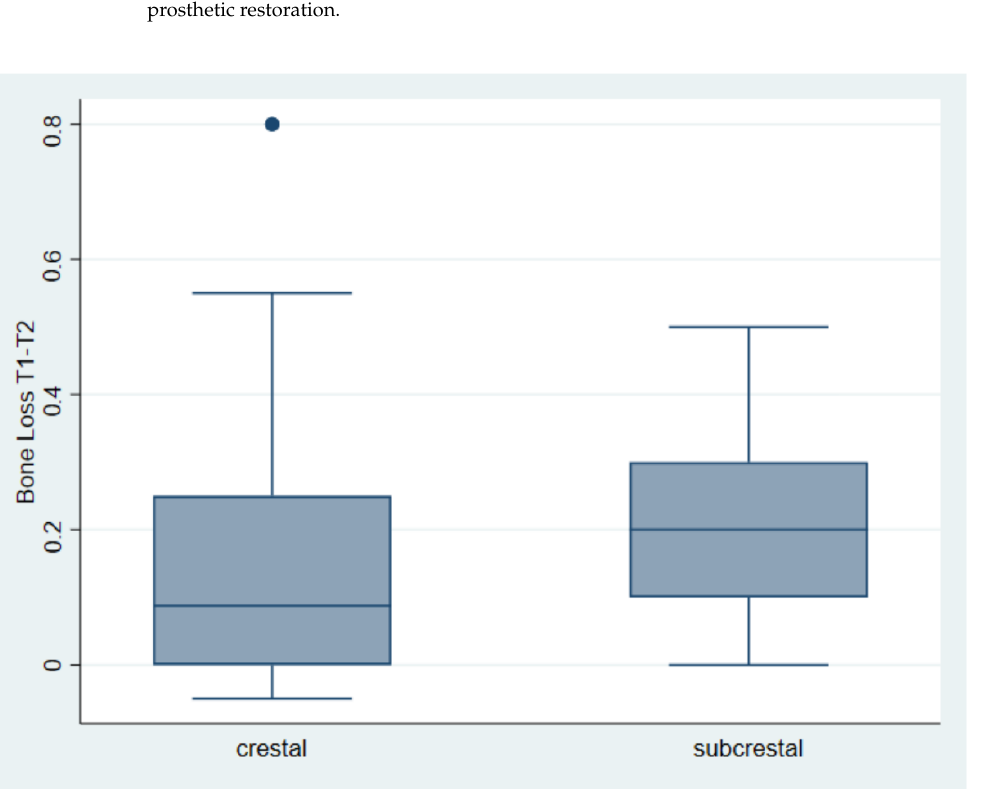
Figure 4. Bone loss (mm) in crestal vs. subcrestal implants between the second and third measurement (T1 – T2). 0.17 mm for the crestal placement and 0.22 mm for the subcrestal placement.